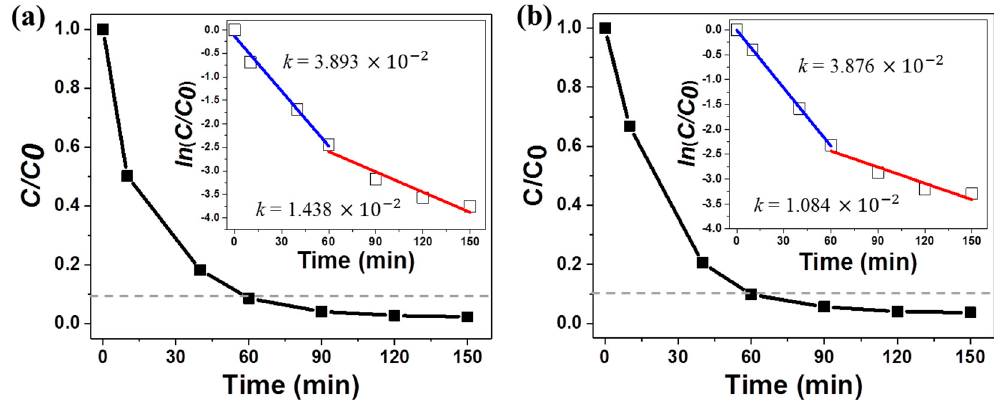
Figure 6. Photodegradation of an MB aqueous solution in the presence of 0.002 wt% TiO 2 /Ag NW composite nanomaterials under ( a ) UV-visible light and ( b ) visible light. The inset figures show the linear fits to ln ( C / C 0 ) vs. time.